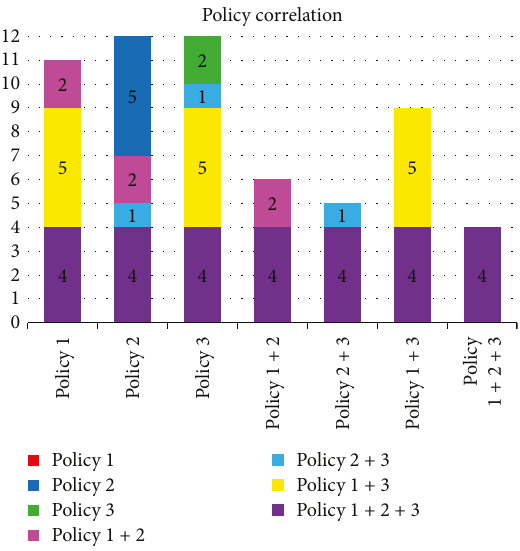
Figure 6: Overall view of the parameter value combinations and their correlations among policies 1, 2, and